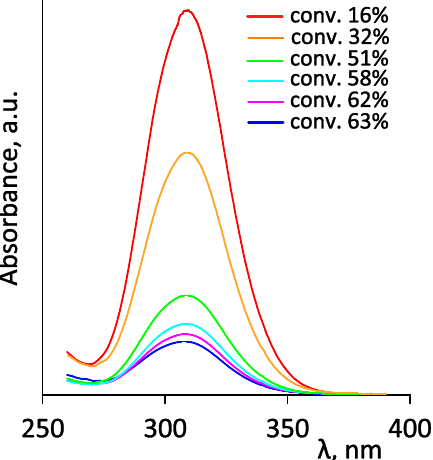
Figure 9. UV–vis spectra of MPEGMA–AOEGMA copolymers in acetonitrile (Ph11 series). Maximum absorption wavelength λmax = 307 nm.